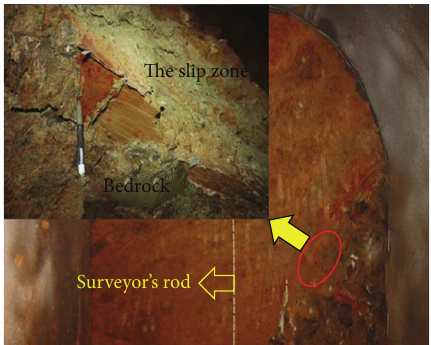
Figure 3: Slip zone of the Huangtupo landslide in No. 3 branch tunnel.